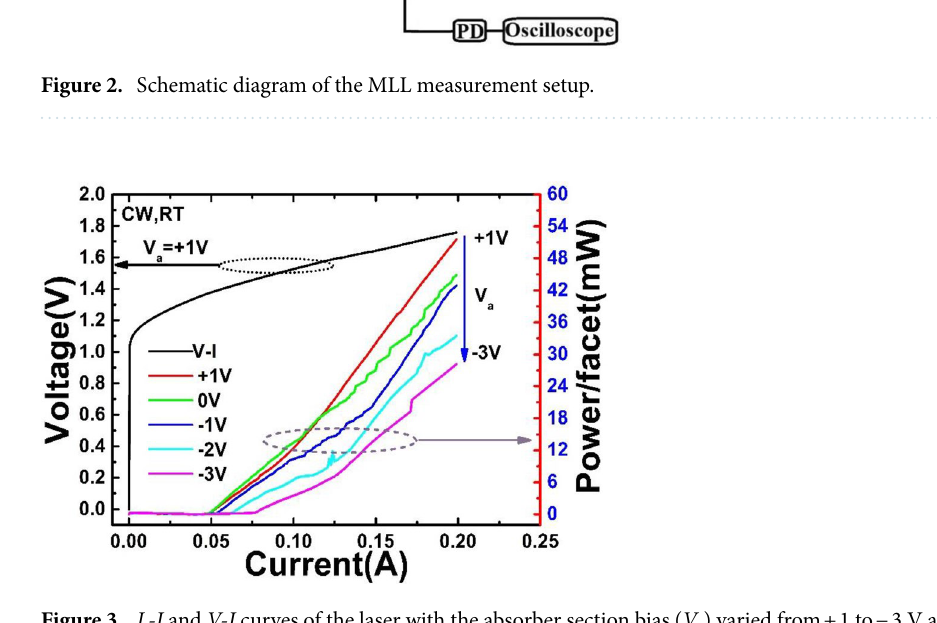
Figure 3. L-I and V-I curves of the laser with the absorber section bias ( V a ) varied from + 1 to − 3 V at room